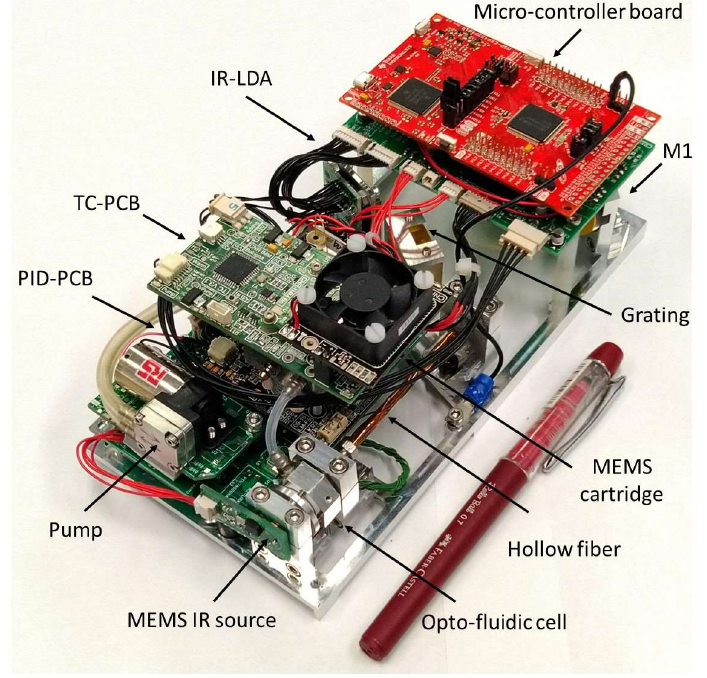
Figure 6. LIRAS sensor prototype.